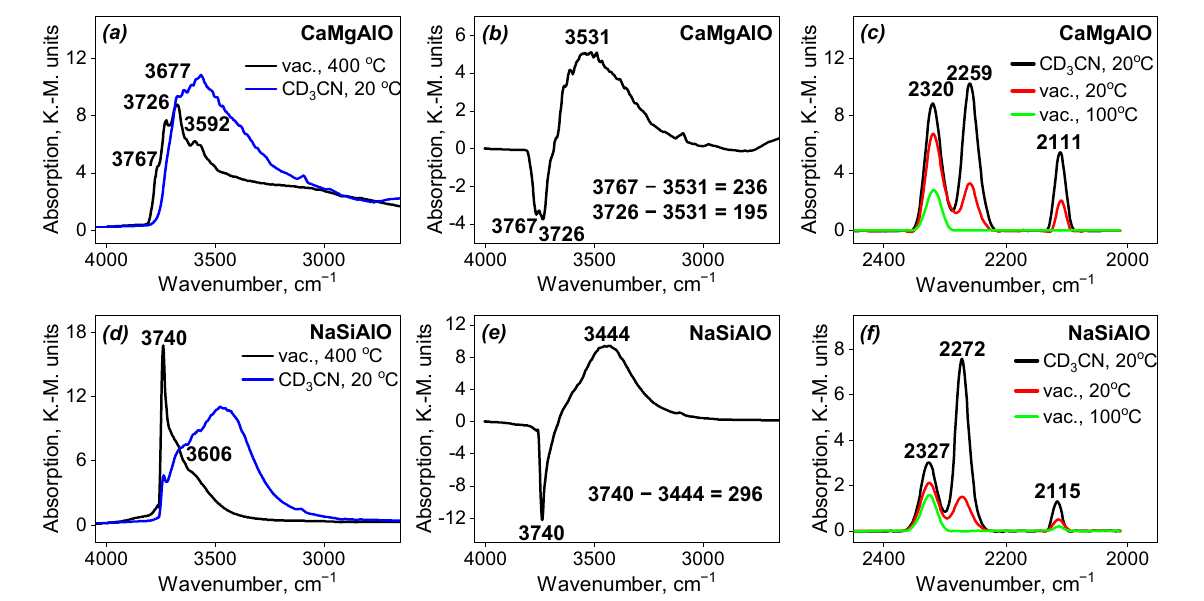
Figure 10. Spectra of mixed-component supports: ( a , d ) DRIFT-OH after evacuation and after ad- sorption of CD 3 CN; ( b , e ) difference of the DRIFT-OH spectra before and after adsorption of CD 3 CN; ( c , f ) DRIFT-CD3CN adsorption-desorption spectra of the support. The strength of Broensted acid sites increases in the order: SiO 2 ≅ NaSiAlO > CaM- gAlO > Al 2 O 3 (Table 2). The strength of Lewis acid sites is about the same for all the sam- ples, excluding SiO 2 , which does not demonstrate any Lewis acidity.